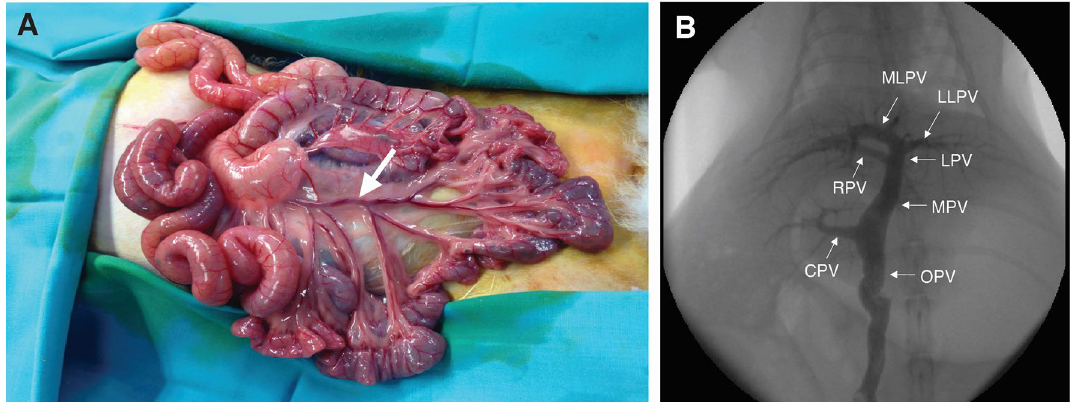
Figure 2. Direct portography technique and rabbit liver portal anatomy. ( A ) Exposition of the small bowel after laparotomy, showing a branch of the superior mesenteric vein (white arrow). ( B ) Direct portography shows the conventional liver rabbit portal anatomy: the original portal vein (OPV) divides into the main portal vein (MPV) and caudate portal vein (CPV). The MPV then bifurcates into the right portal vein (RPV) and left portal vein (LPV) which subsequently divided into medial left portal vein (MLPV) and lateral left portal vein (LLPV).